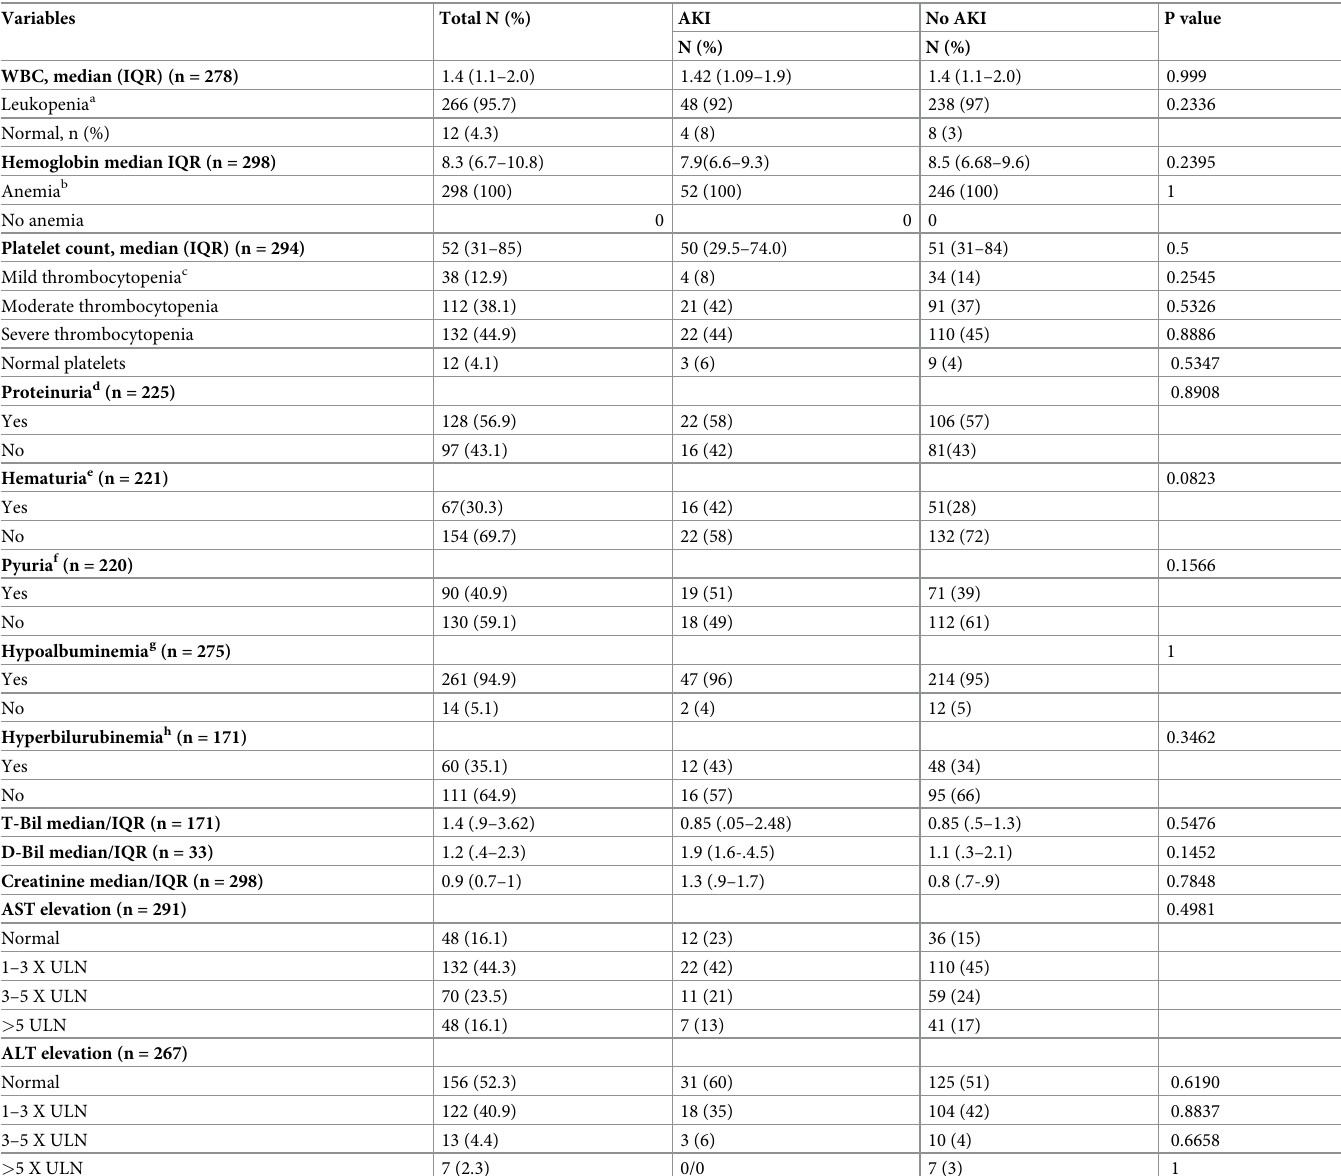
Table 2. Baseline laboratory characteristics of VL patients at LRTC between January 2019 –December 2019, Gondar, Ethiopia, N =